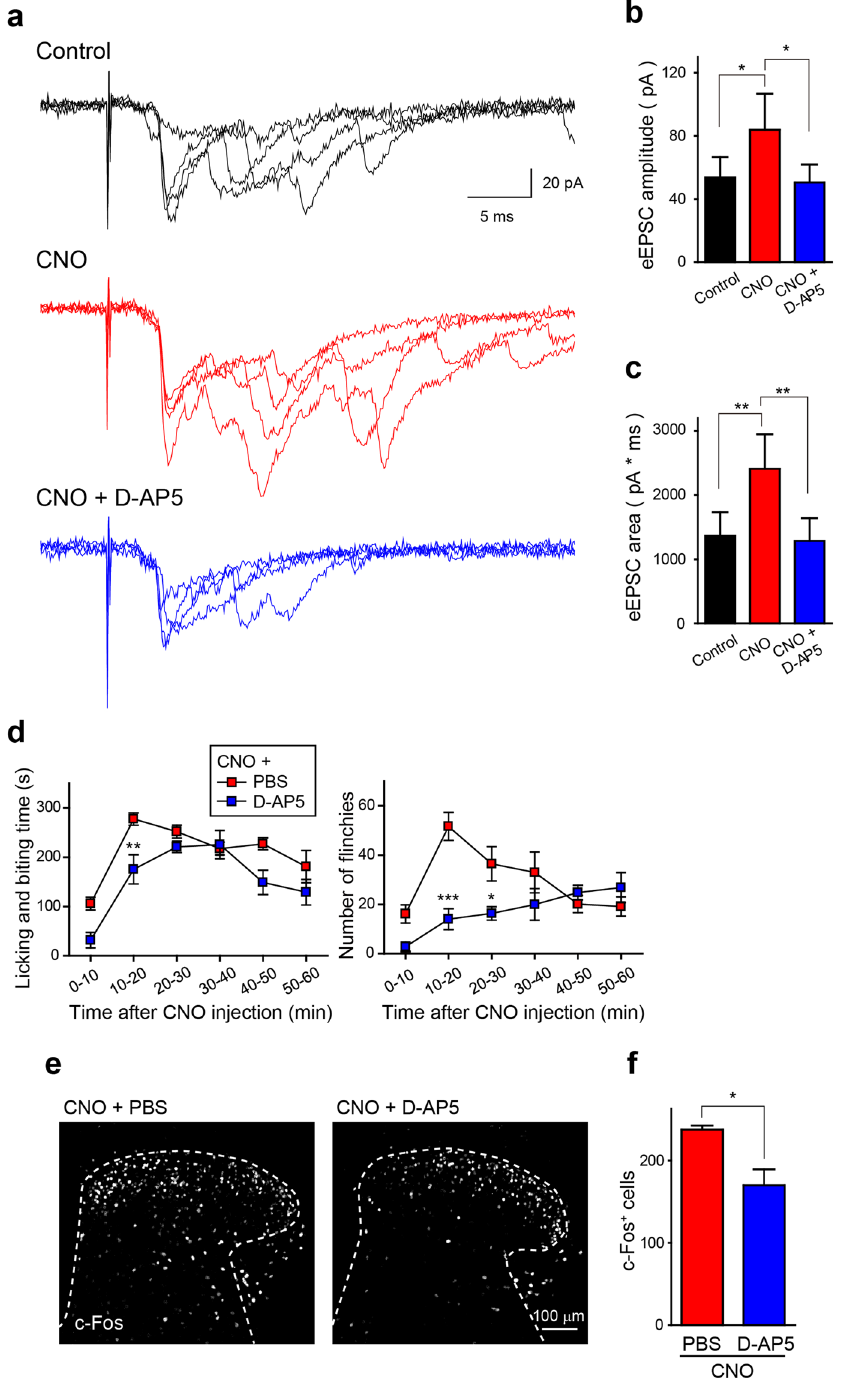
Figure 3. CNO-induced facilitation of A fibre-mediated polysynaptic responses in lamina II neurons of Vgat- Cre ;AAV-hM4Di FLEX mice. ( a ) Representative polysynaptic excitatory postsynaptic currents (EPSCs) evoked by A fibres stimulation (100 μ A for 100 μ s) in Vgat-Cre neg lamina II neurons before (top) and after bath application of CNO (10 μ M; middle) and CNO with D-AP5 (50 μ M; bottom). ( b ) Quantification of the amplitude of polysynaptic A fibre-evoked EPSCs (eEPSCs) (n = 6; * P < 0.05). ( c) Quantification of the area of eEPSCs. Area was calculated by measuring the integrated area of eEPSCs (0–200 ms) (n = 6; ** P < 0.01). ( d,e ) Effect of intrathecal pretreatment with D-AP5 (5 μ g/5 μ L) or PBS on the CNO-induced nocifensive behaviours (left, licking and biting; right, flinching) (( d) n = 6, * P < 0.05, ** P < 0.01, *** P < 0.001 vs. CNO + PBS) and on the CNO-induced increase in c-Fos + cells in the SDH. c-Fos immunoreactivity in the SDH ( e ) and quantification (( f) n = 6, * P < 0.05). Data are means ±